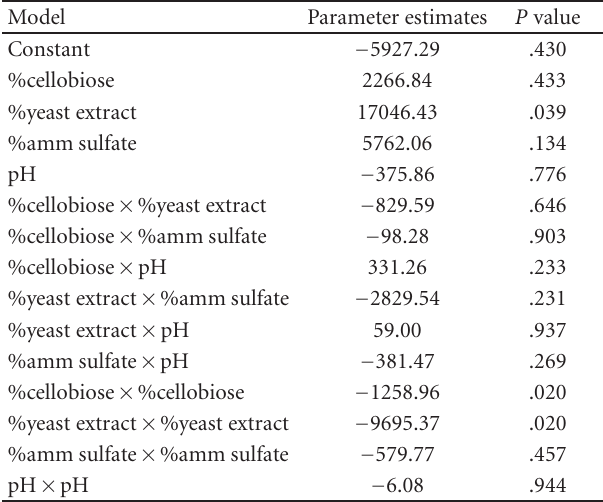
Table 5: Estimated regression coe ffi cients for β -glucosidase pro-